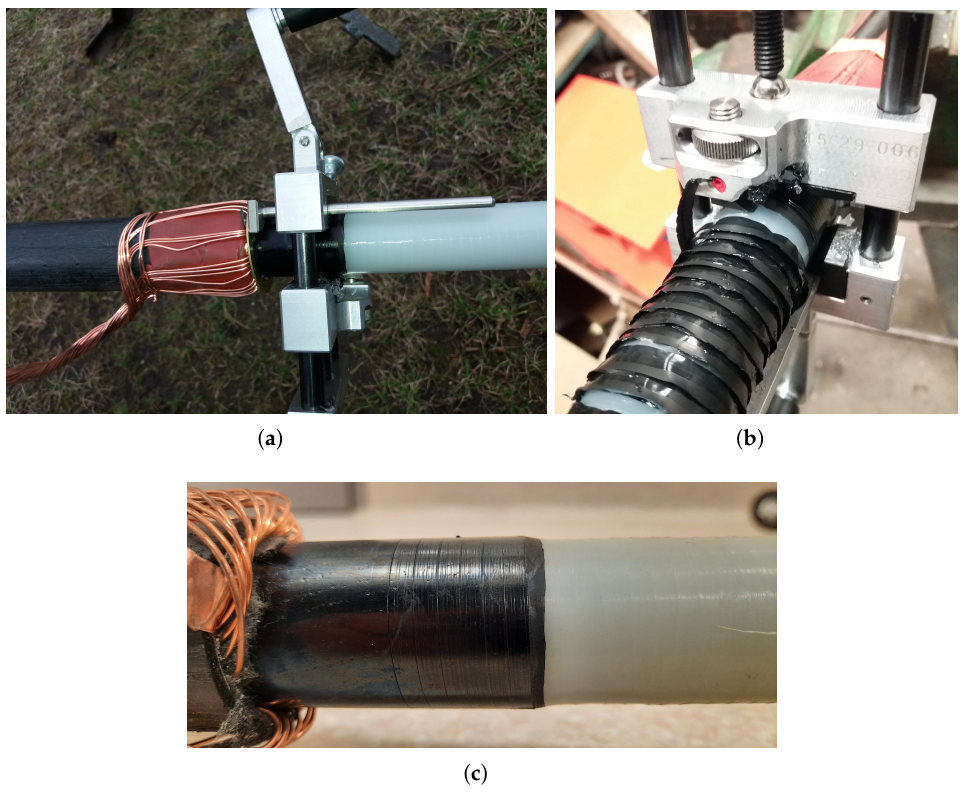
Figure 2. Process of preparing cable type XRUHAKXS 1 × 240/25 for installation of MV cable accessories: ( a ) device for removing shield from the insulation, ( b ) action removing shield from the cable insulation, ( c ) view of the cable shield after improper use of the device